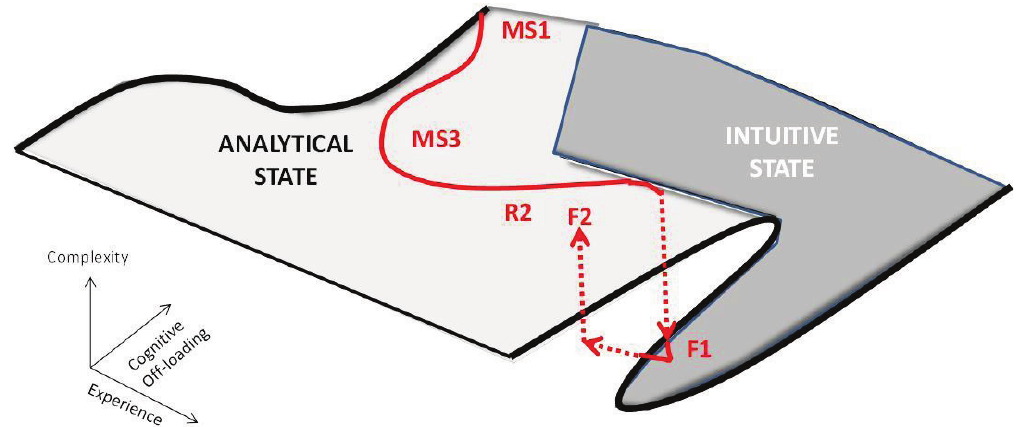
Figure 6. The cognitive landscape showing a critical fold, typical learner trajectory (in red) and a critical state change that occurs with combinations of experience and cognitive